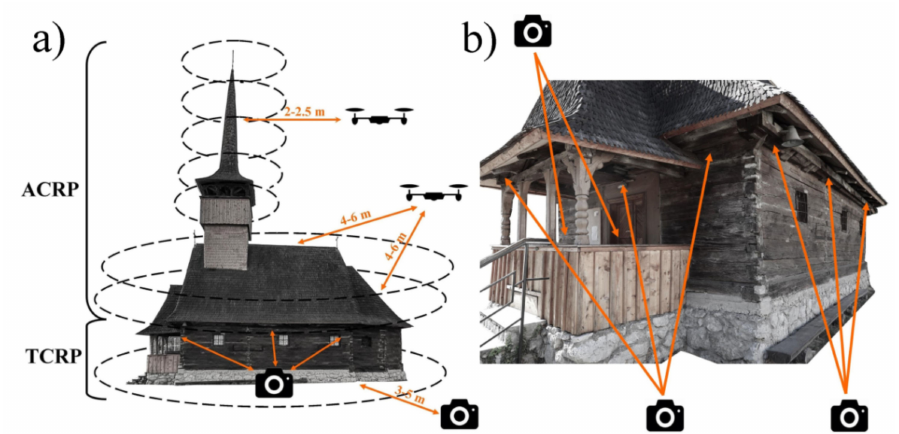
Figure 4. The methodology for acquiring photographs for the creation of three-dimensional models of the exterior of monuments; ( a )—acquisition of photographs via ACRP and TCRP and ( b )—acquisition of photographs so as to limit